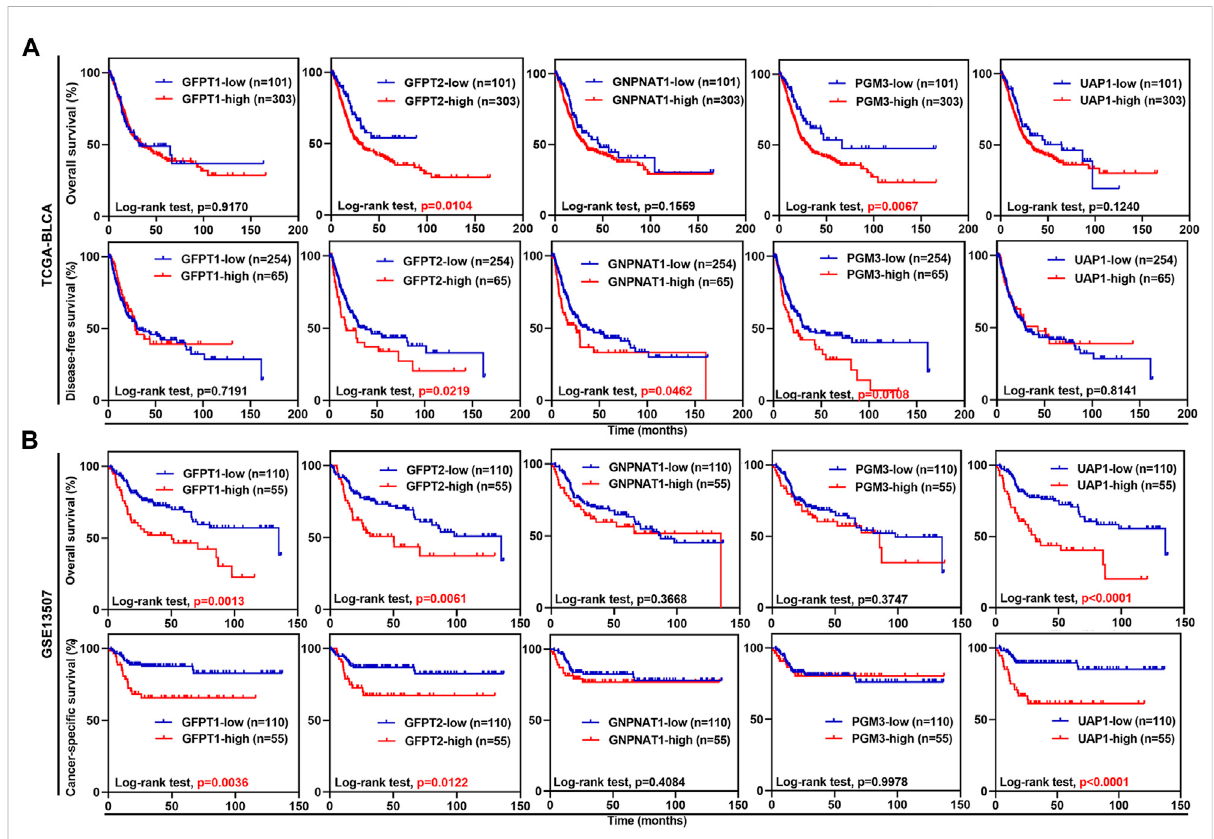
FIGURE 2 The associations between the expression levels of fi ve HBP genes and clinical outcomes in UBC patients from TCGA-BLCA and GSE13507 datasets. (A,B) Kaplan-Meier plot of overall survival, disease-free survival or cancer-speci fi c survival for UBC patients in TCGA-BLCA (A) andGSE13507 (B) datasets,strati fi edbythemRNAlevelsoftheindividualHBPgene.SurvivalprobabilitywascalculatedusingLog-ranktest. p values < 0.05 were labelled in